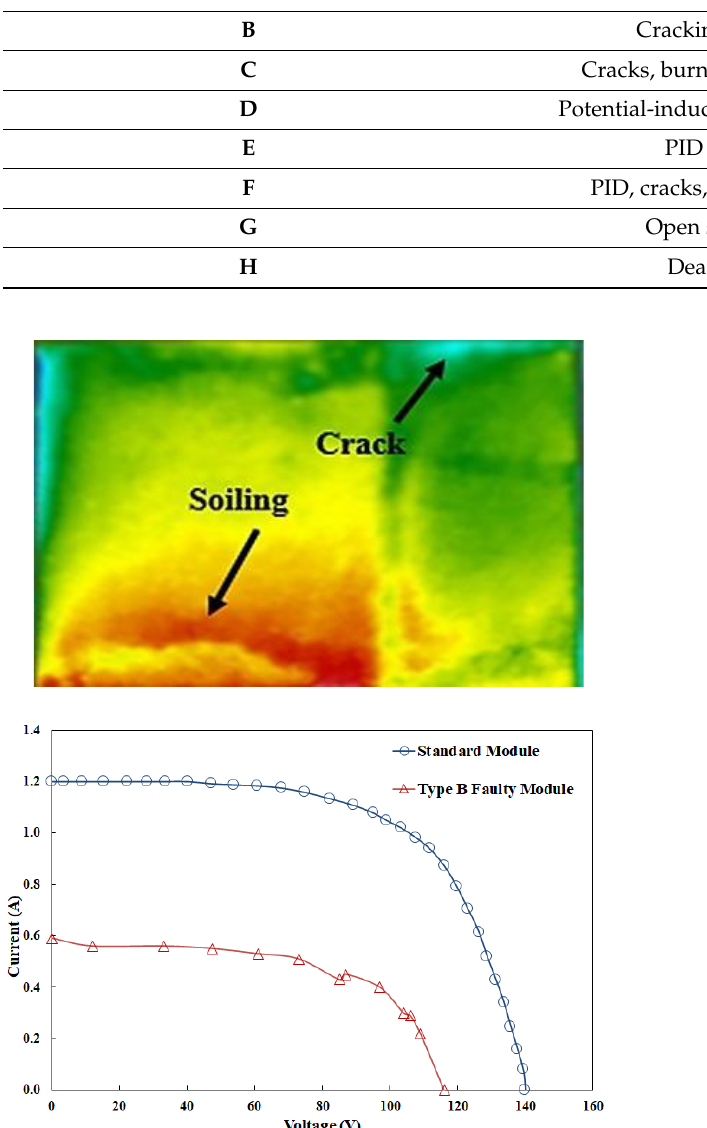
Table 2. Categories of CIGS PV module faults .